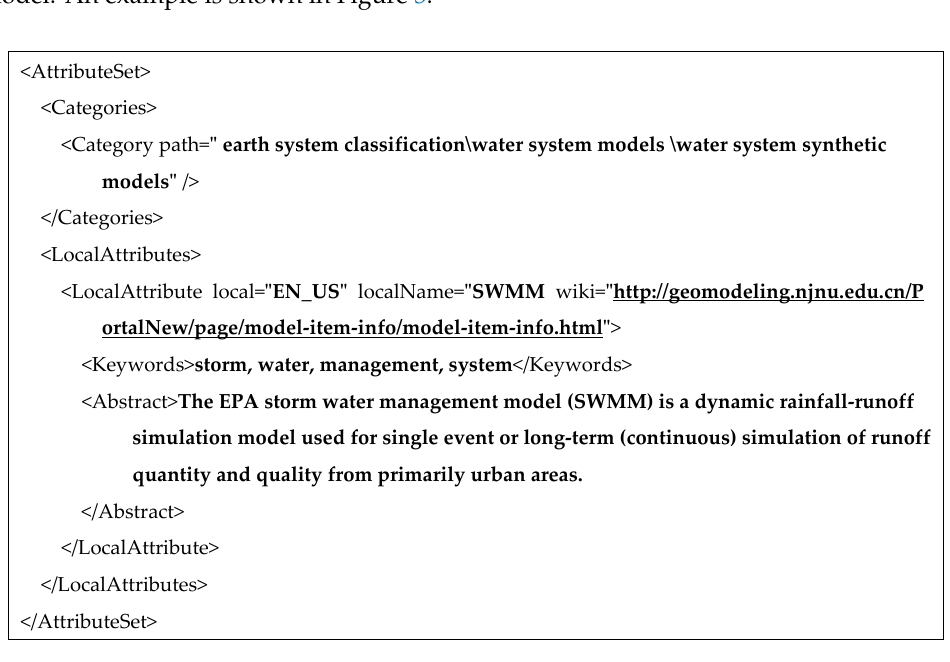
Figure 3. Description of the model in the MDL.